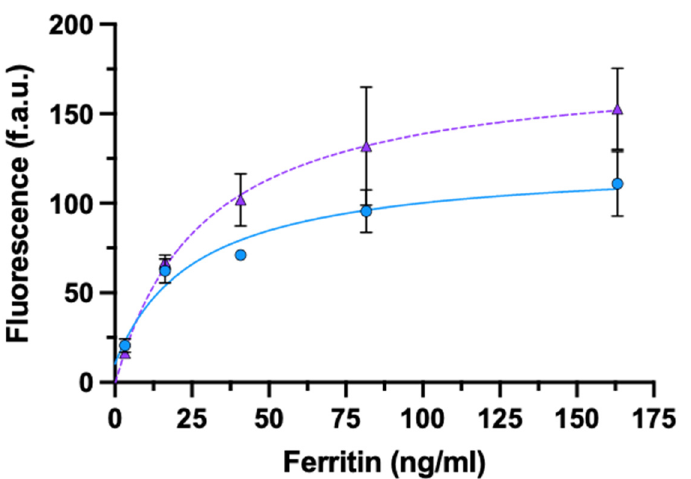
Figure 6. ELISA for the detection of ferritin using oriented monovalent rIgG (circle) or non-oriented bivalent IgG (triangle). Data are presented as mean ± SD ( n = 4) . Fitting equations: rIgG (solid line) y = (10.32 + 4.75x)/(1 + 0.04x); IgG (dashed line) y = ( − 1.26 + 6.30x)/(1 + 0.04x).